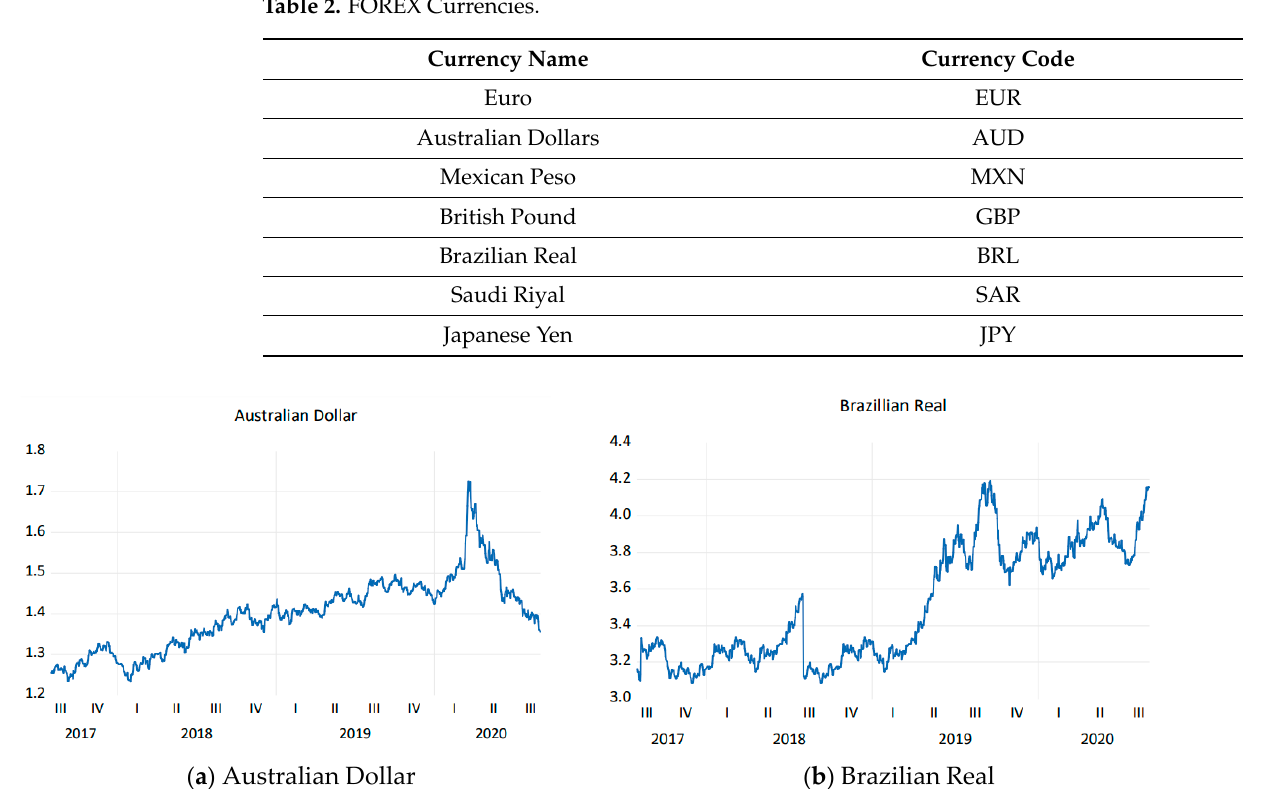
Figure 3. Daily time series of FOREX currencies with Australian dollar and Brazilian real.